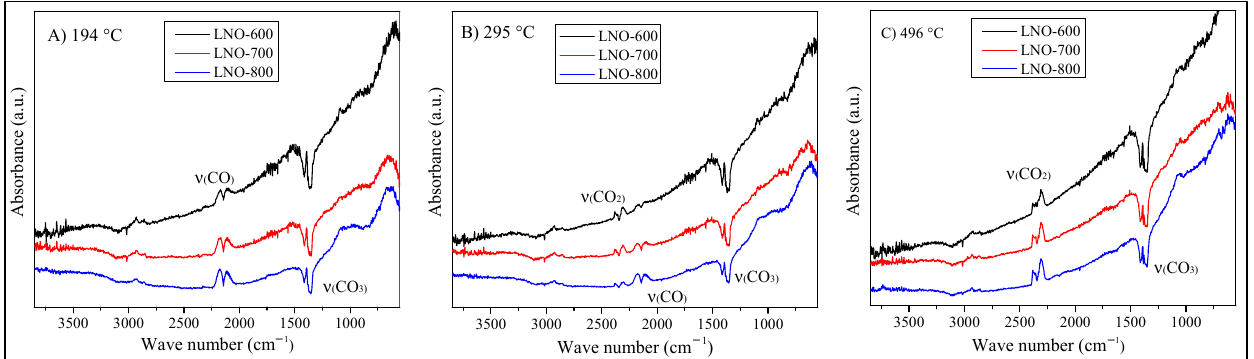
Figure 14. DRIFTS spectra obtained at 194 ( A ), 295 ( B ), and 496 °C ( C ), using the different LaNiO 3 catalysts during the CO oxidation process.